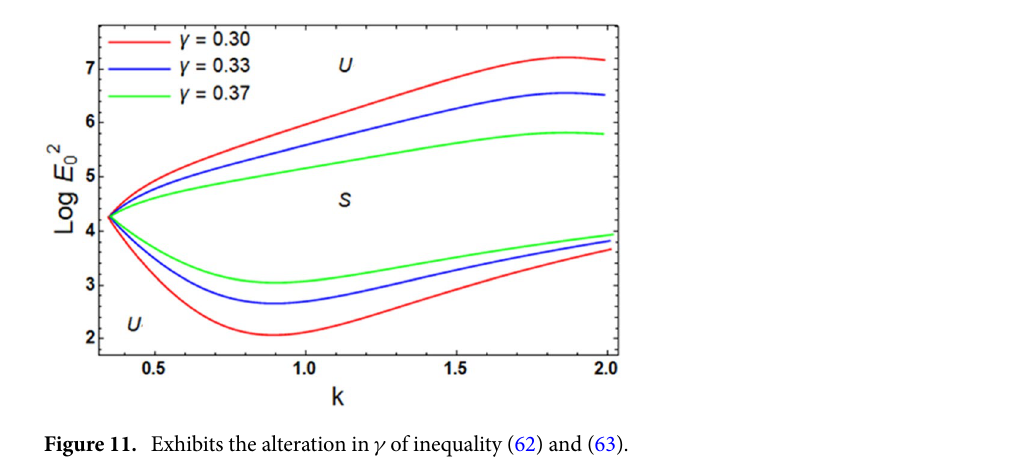
Figure 11. Exhibits the alteration in γ of inequality (62) and (63).